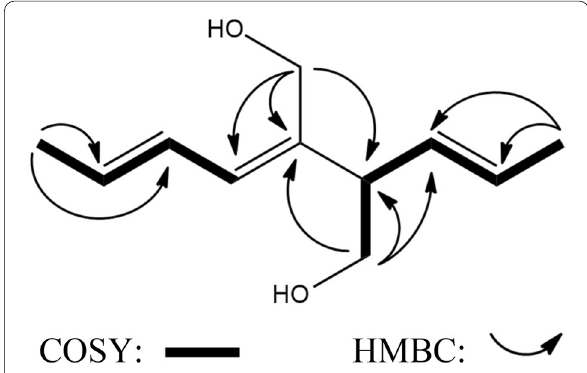
Fig. 1 Key HMBC and COSY correlations for compound